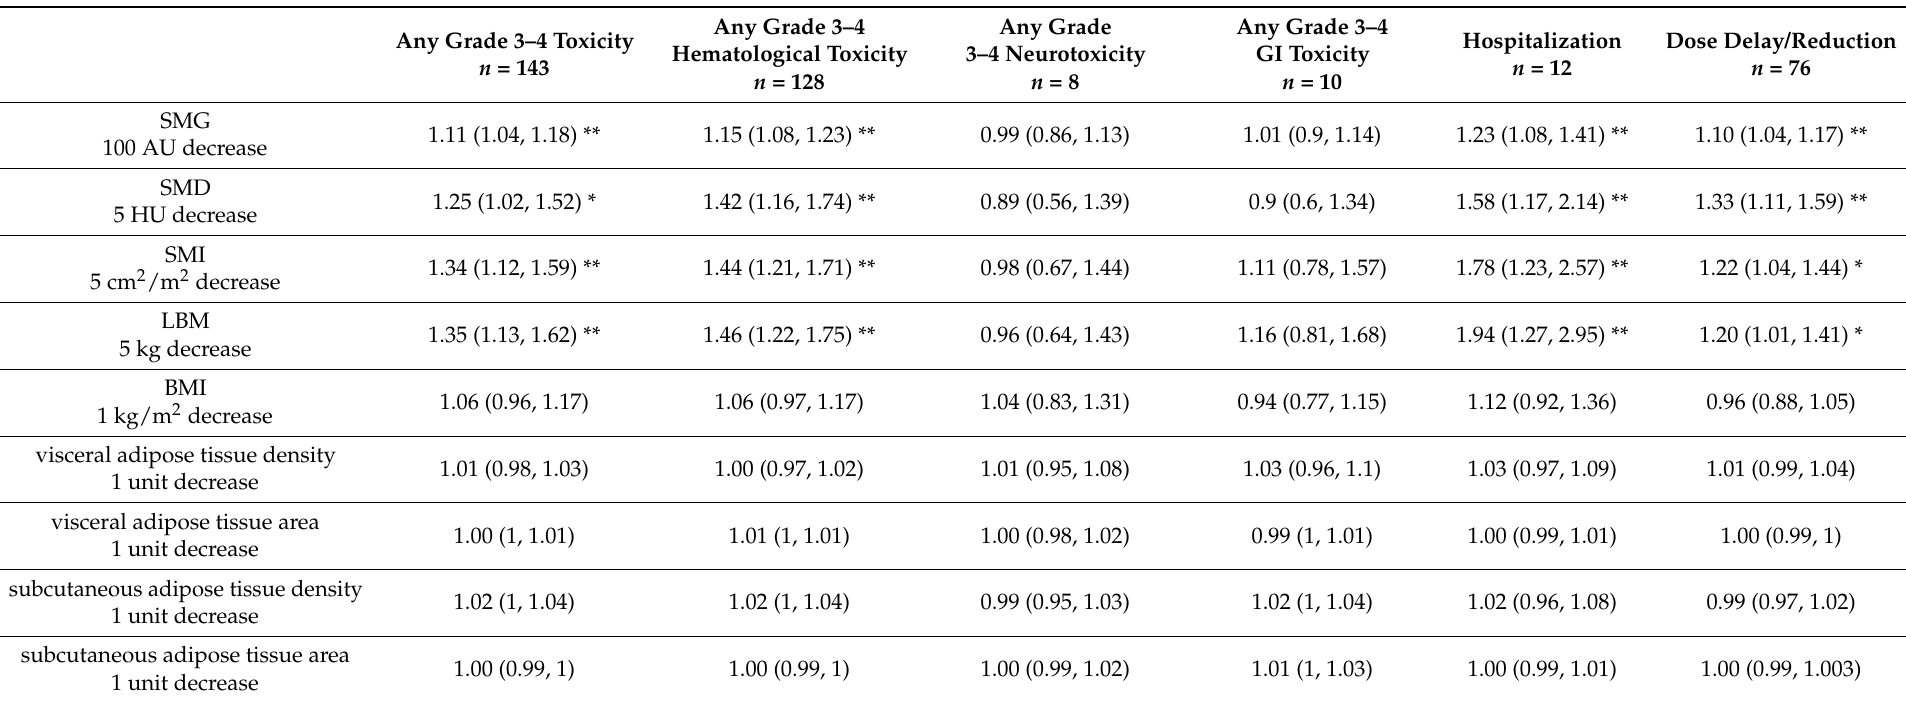
Table 2. Relative risk (RR) (95% Confidence Interval) of toxicity for body composition